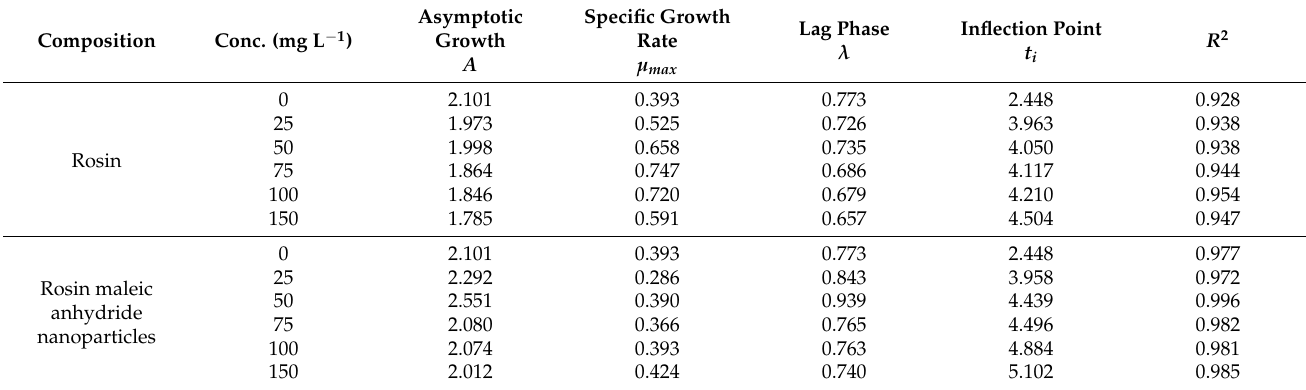
Table 3. Gompertz kinetics of MRSE culture treated with rosin and rosin maleic anhydride nanoparti-